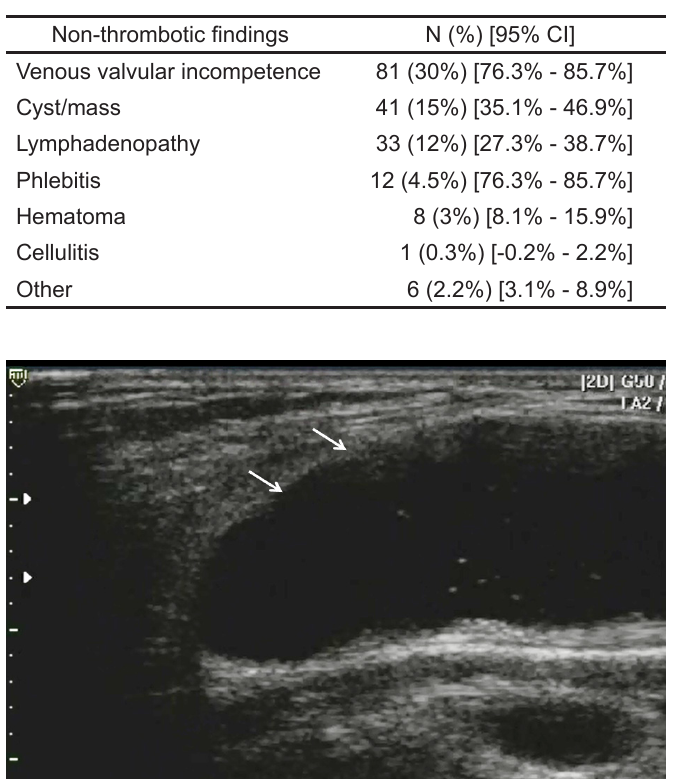
Table. Non-thrombotic findings detected in lower extremity venous duplex ultrasound